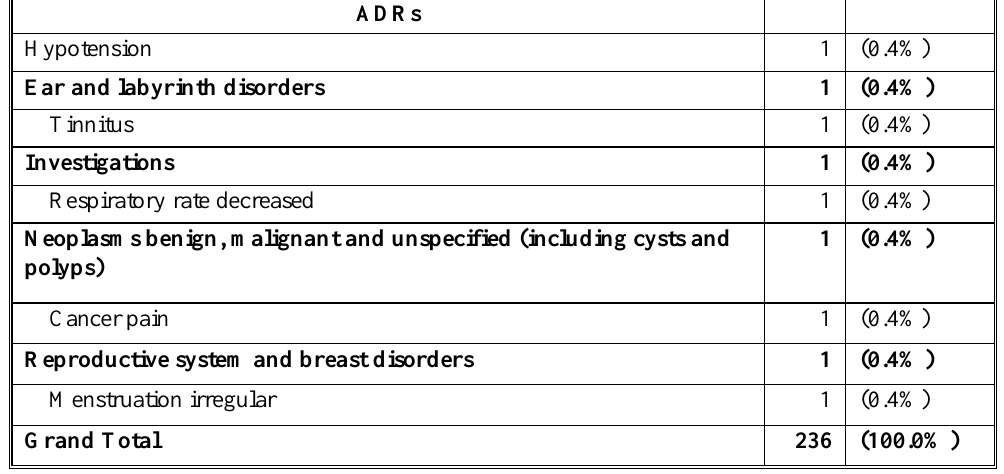
Table 7. Causality, severity,